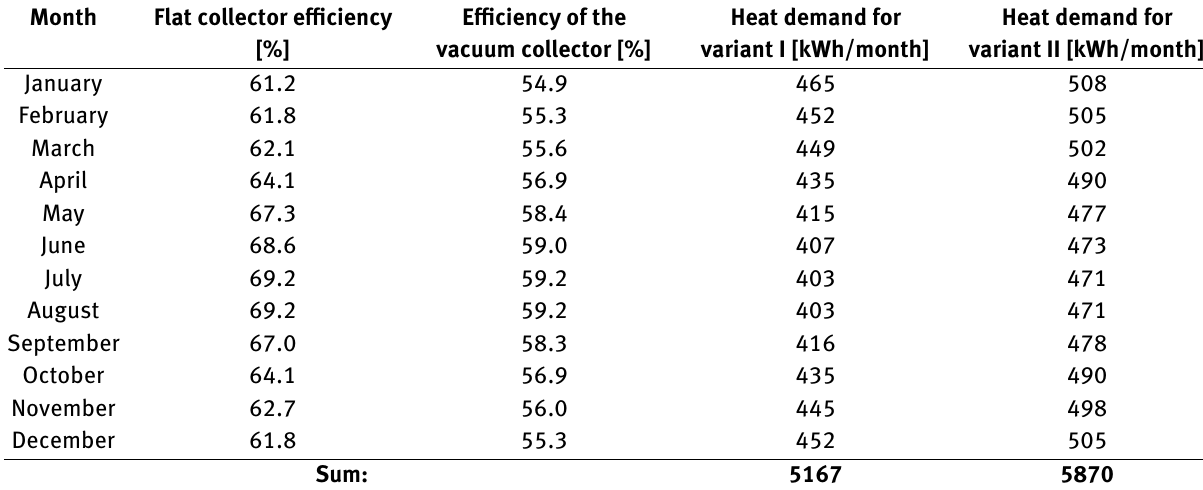
Table 2: Total heat demand.